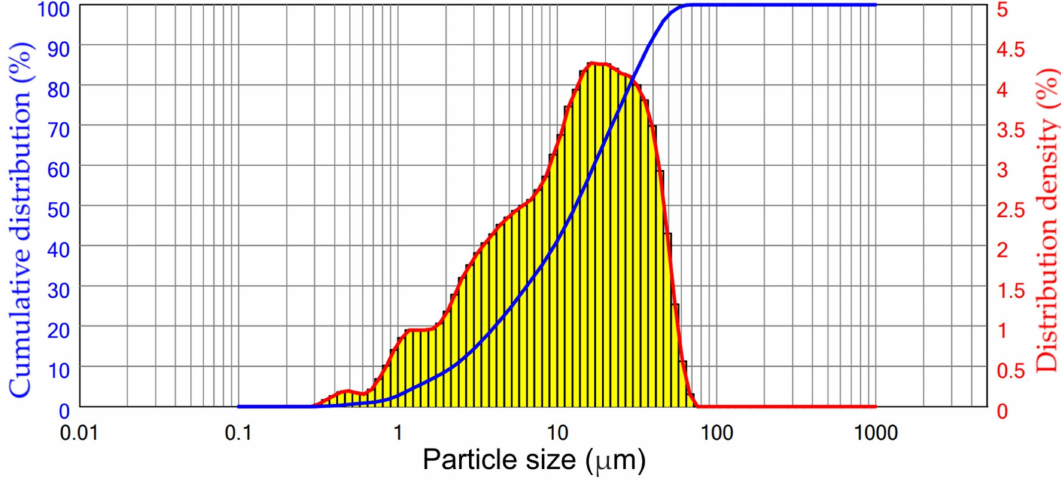
Figure 6. The particle size distribution of DCFA used in the REEs leaching experiments.